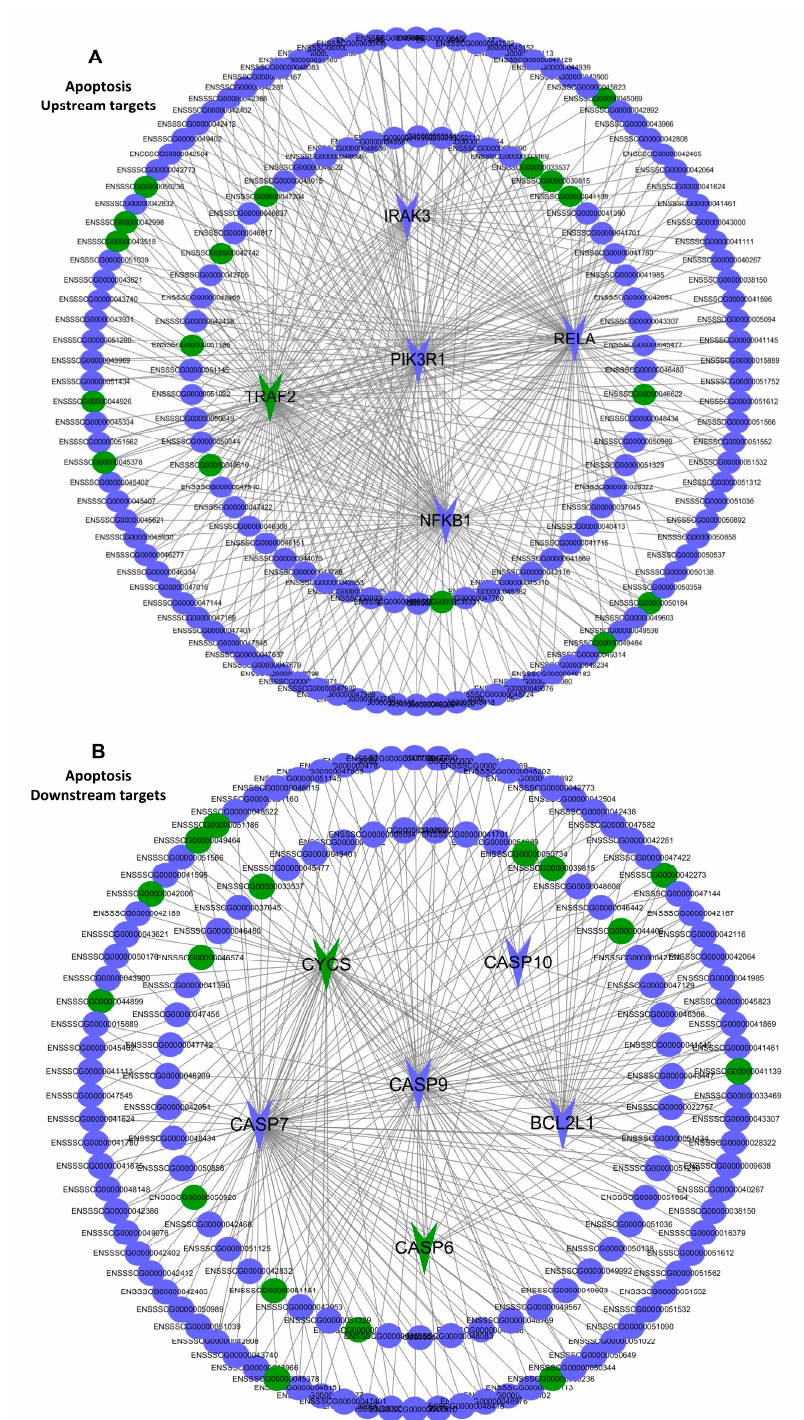
Figure 8. The interaction between the differentially expressed mRNAs and lncRNAs associated with apoptosis in the PTR2 cells infected with PRRSV. Network analysis provides a global view of all the possible lncRNA- mRNA expression associations based on the different upstream targets of apoptosis backgrounds ( A ) and downstream targets of apoptosis backgrounds ( B ) in the PRRSV-infected PTR2 cells. Upstream targets of mRNAs include TRAF2, NFKB1, RELA, PIK3R1, and IRAK3. Downstream targets of mRNAs include CYCS, BCL2L1, CASP6, CASP7, CASP9, and CASP10. Other targets are lncRNAs, which are predicted to regulate mRNA expression. The arrows represent mRNAs and the ellipses represent lncRNAs. Blue means up-regulation, green means down-regulation.